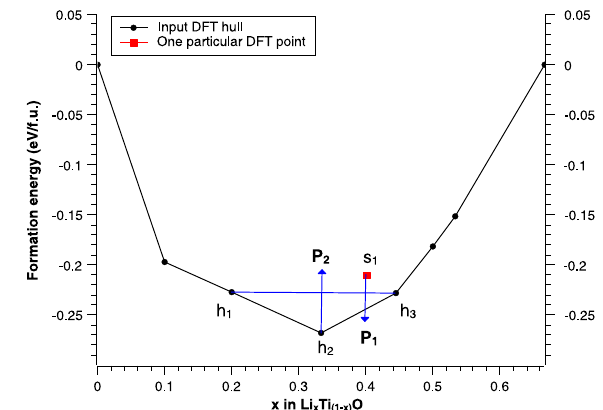
Fig. 1 Schematic of the two types of ground-state inconsistencies that may arise during the fi t of a cluster expansion (CE) model to DFT reference data. (P 1 ) illustrates the situation in which one particular con fi guration, s 1 , that is unstable based on the DFT input data becomes a stable ground-state of the CE model, as its CE energy is below the convex combination of its decomposition line de fi ned by the ground-state con fi gurations h 2 and h 3 . (P 2 ) illustrates the converse situation in which the CE energy of one ground-state con fi guration, h 2 , is greater than the convex combination of the neighboring ground states, h 1 and h 3 , which causes h 2 to be unstable in the CE